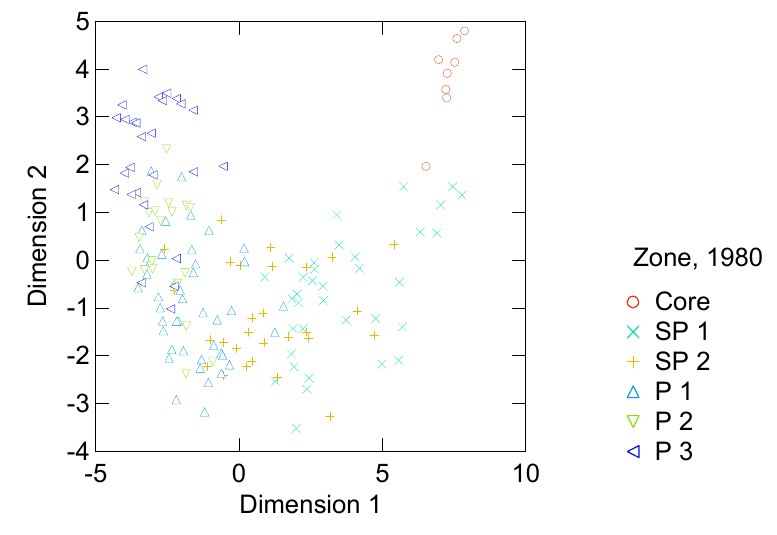
Figure 4: Exponential Distance Model with Hierarchical Clustering of Regular Equivalencies Superimposed,